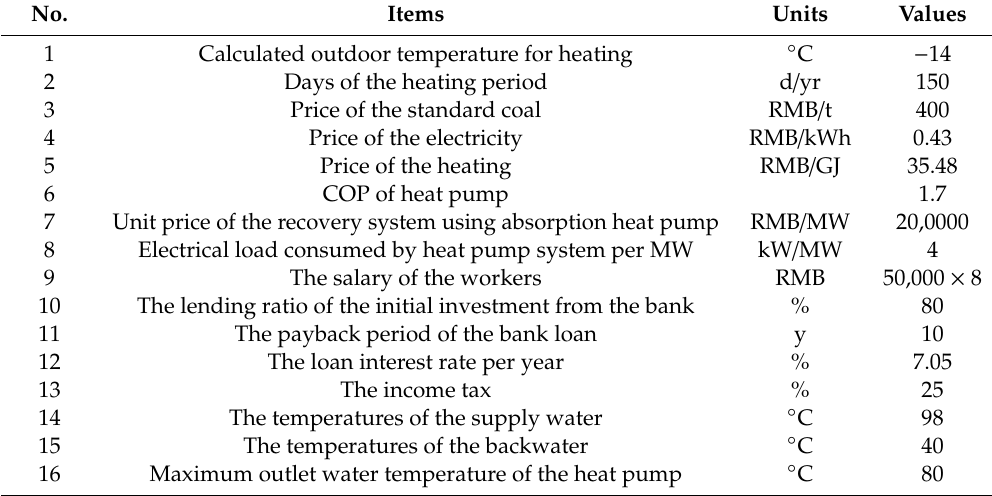
Table 2. The main original data for the system